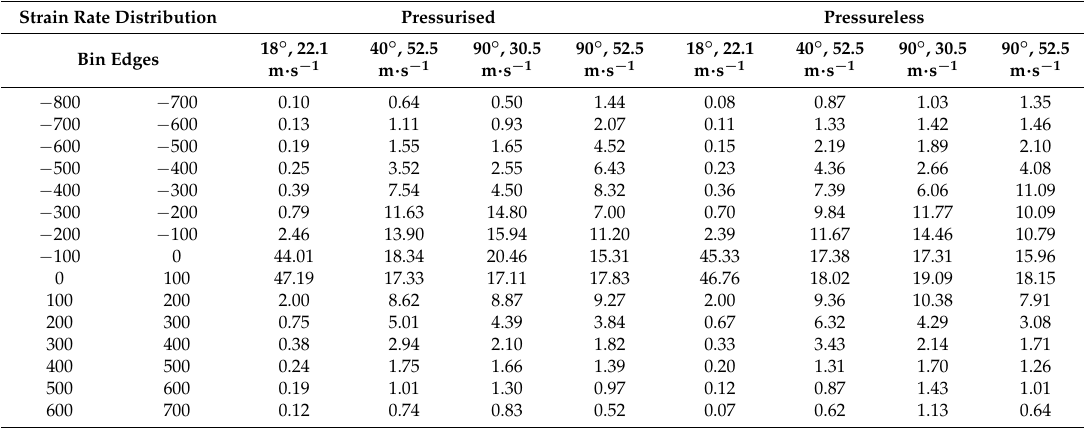
Table 6. Percentage distribution of strain rate during